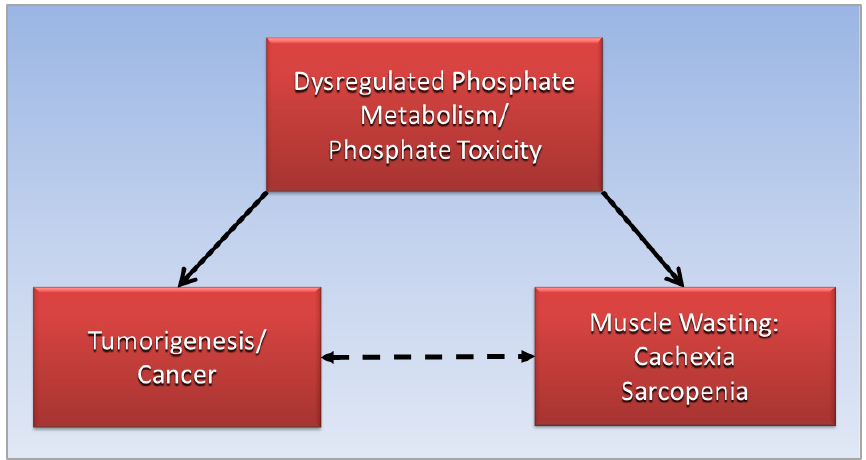
Figure 3. Dysregulated phosphate metabolism and phosphate toxicity mediate the association of cancer with cachexia.